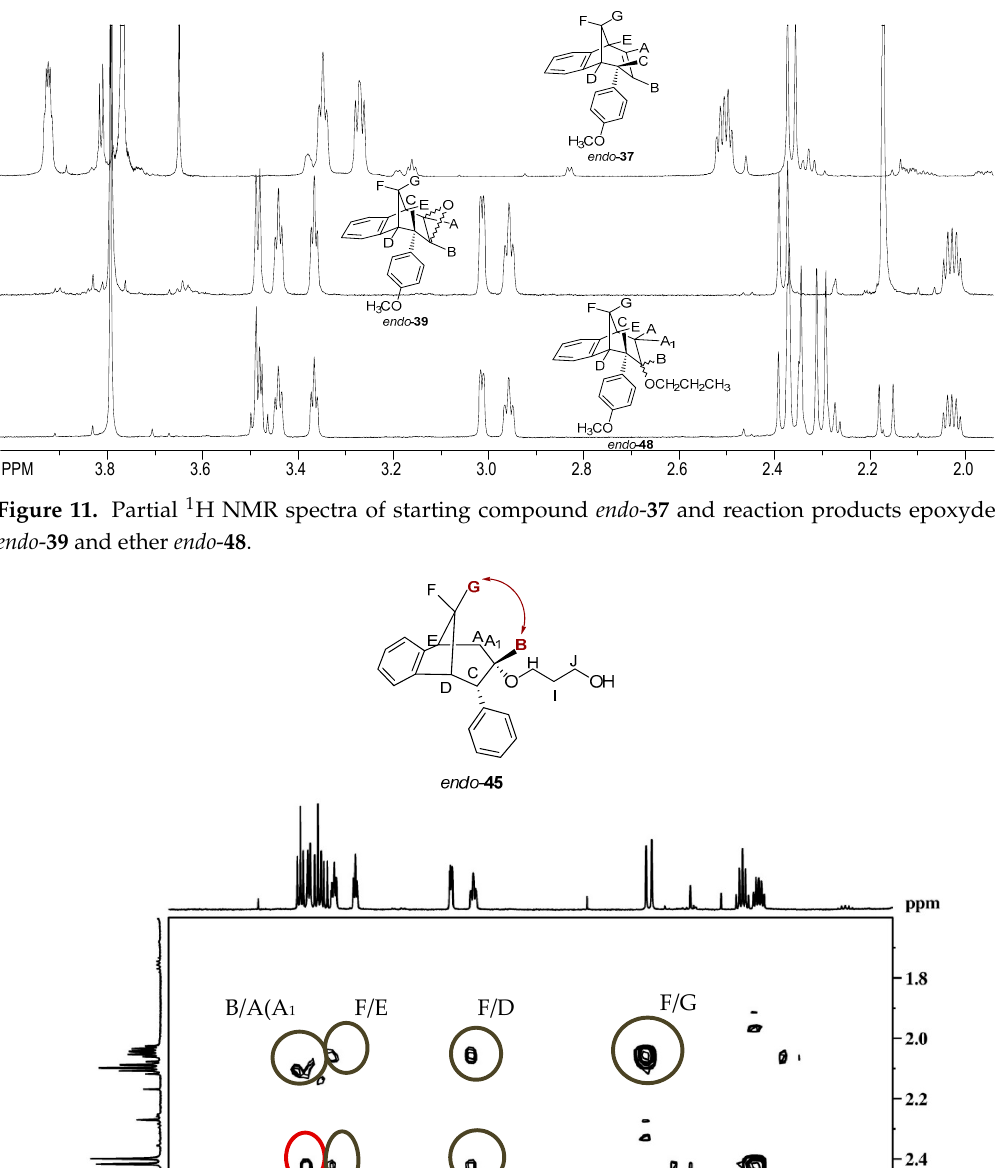
Figure 11. Partial 1 H NMR spectra of starting compound endo - 37 and reaction products epoxyde endo - 39 and ether endo - 48 .